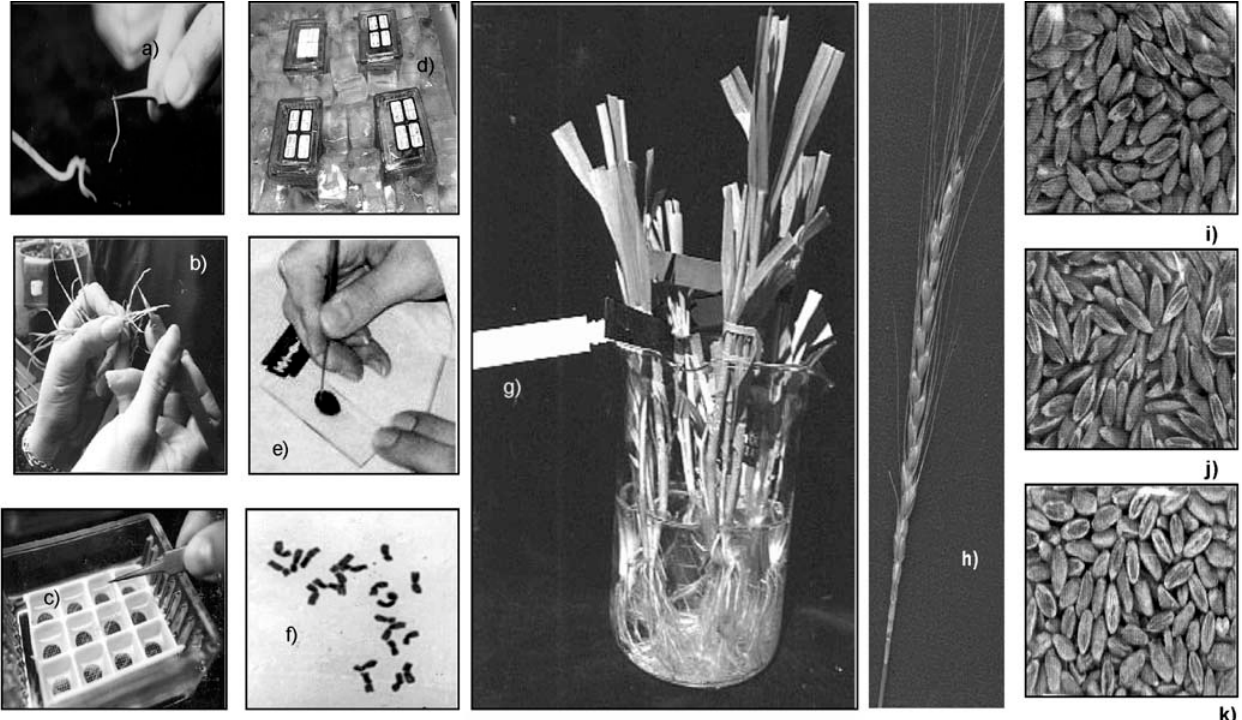
Figure 3 - After root tips ice pre-treatment ( a , b , c , d ), chromosome counting confirms sucessful hybridization ( e , f ). The new tillers that will develop after colchicine treatment ( g ), will present genomes duplication and consequently, fertility is restaured ( h ). The new fully homozygous hexaploid lines, 2n = 42, AABBDD obtained ( i , j , k ), may now be used to transfer the resistance genes either from T. durum or Ae. squarrosa to susceptible cultivars, by usual crossing procedures of conventional breeding programs without any other special procedure. Seeds of three new synthetic hexaploid lines obtained at Embrapa Trigo (Table I), PF 804001, PF 844004 and PF 844006 are show in i, j and